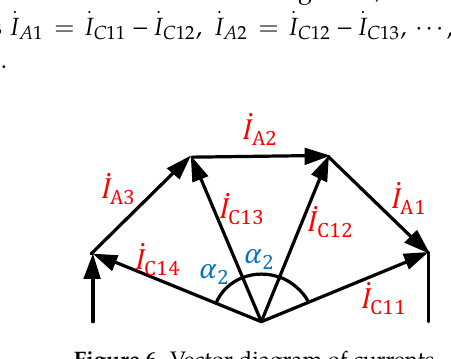
Figure 6. Vector diagram of currents.